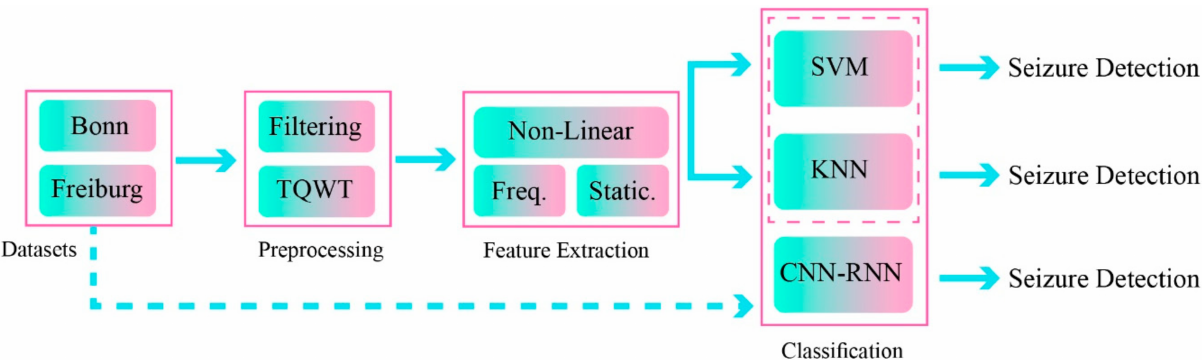
Figure 1. Proposed method for epileptic seizure